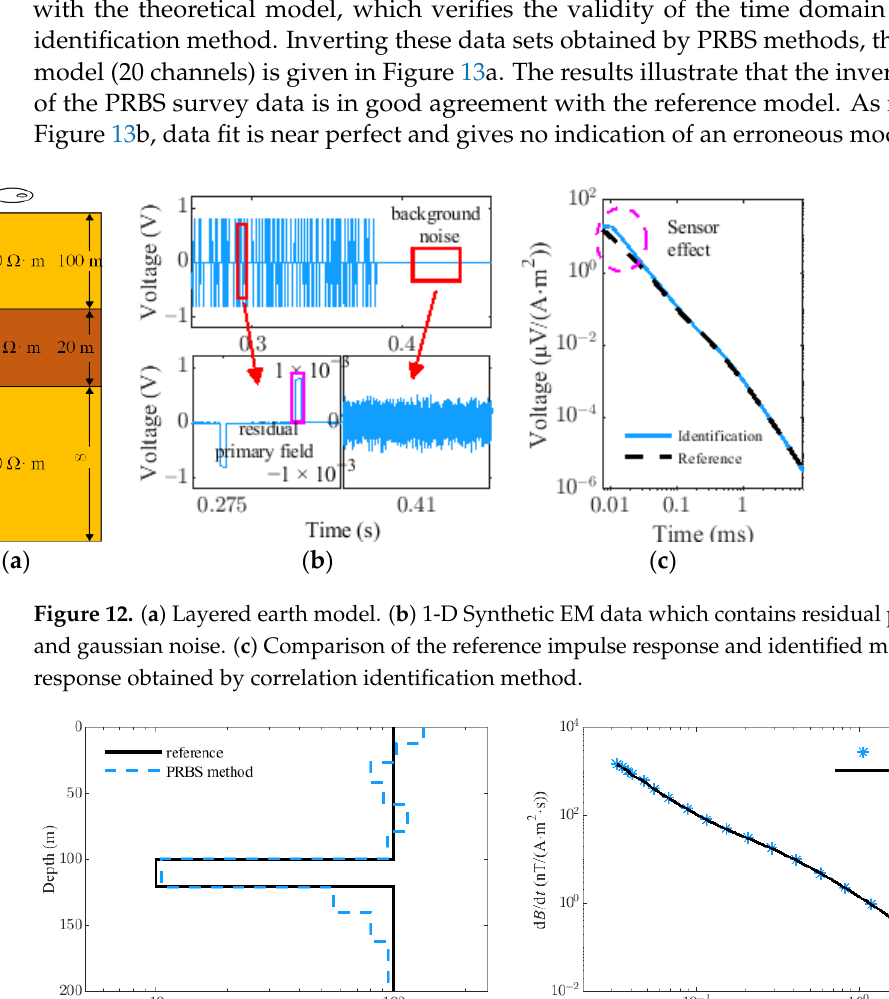
( c ) Figure 11. The comparison of response relative errors between PRBS method and traditional method in different primary field coefficient K: ( a ) K = 1 × 10 − 5 . ( b ) K = 1 × 10 − 4 . ( c ) K = 1 × 10 − 3 .